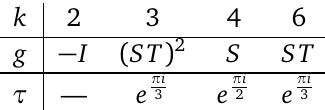
Table 2: S-folds are labelled by k such that (cid:90) is a subgroup of SL ( 2, (cid:90) ) . In each k case, we give a possible generator and the value of τ that it fixes. k 2